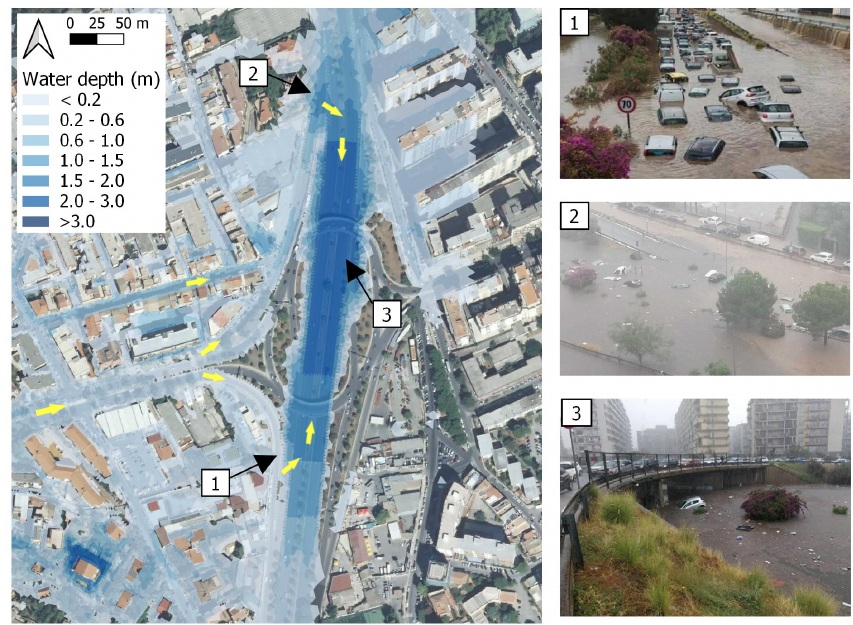
Figure 13. Maximum flood depths for the Michelangelo underpass as simulated in WEC-FLOOD. The yellow arrows indicate the flow directions of the flood. Source: © Google Maps Satellite basemap available within the QuickMapServices plugin of Quantum GIS. Source picture 1: PalermoToday (https://www.palermotoday.it/foto/cronaca/allagamento-palermo-15-luglio-2020-foto/ #allagamento-festino-2020-viale-regione-4.html&gid=1&pid=1, last access: 23 August 2021). Source picture 2: La Repubblica Palermo (https://palermo.repubblica.it/cronaca/2020/07/15/news/palermo_-262015602/, last access: 23 August 2021). Source picture 3: Stret- toWeb (http://www.strettoweb.com/foto/2020/07/maltempo-sicilia-alluvione-palermo-morti-dispersi-bambini-ipotermia-foto/1037325/, last access: 23 August